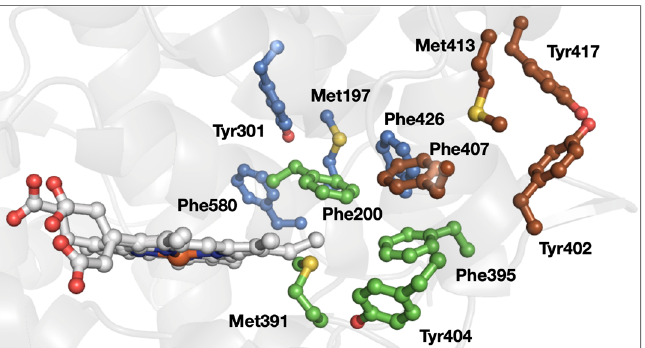
Figure 7. Structure of prostaglandin H2 synthase 1 (PDB ID 1Q4G [54]). The 3-bridge clusters are highlighted in maroon, green, and lavender, and the heme is shown in gray. Red corresponds to oxygen, yellow to sulfur, and blue to nitrogen. The image was generated using PyMOL.